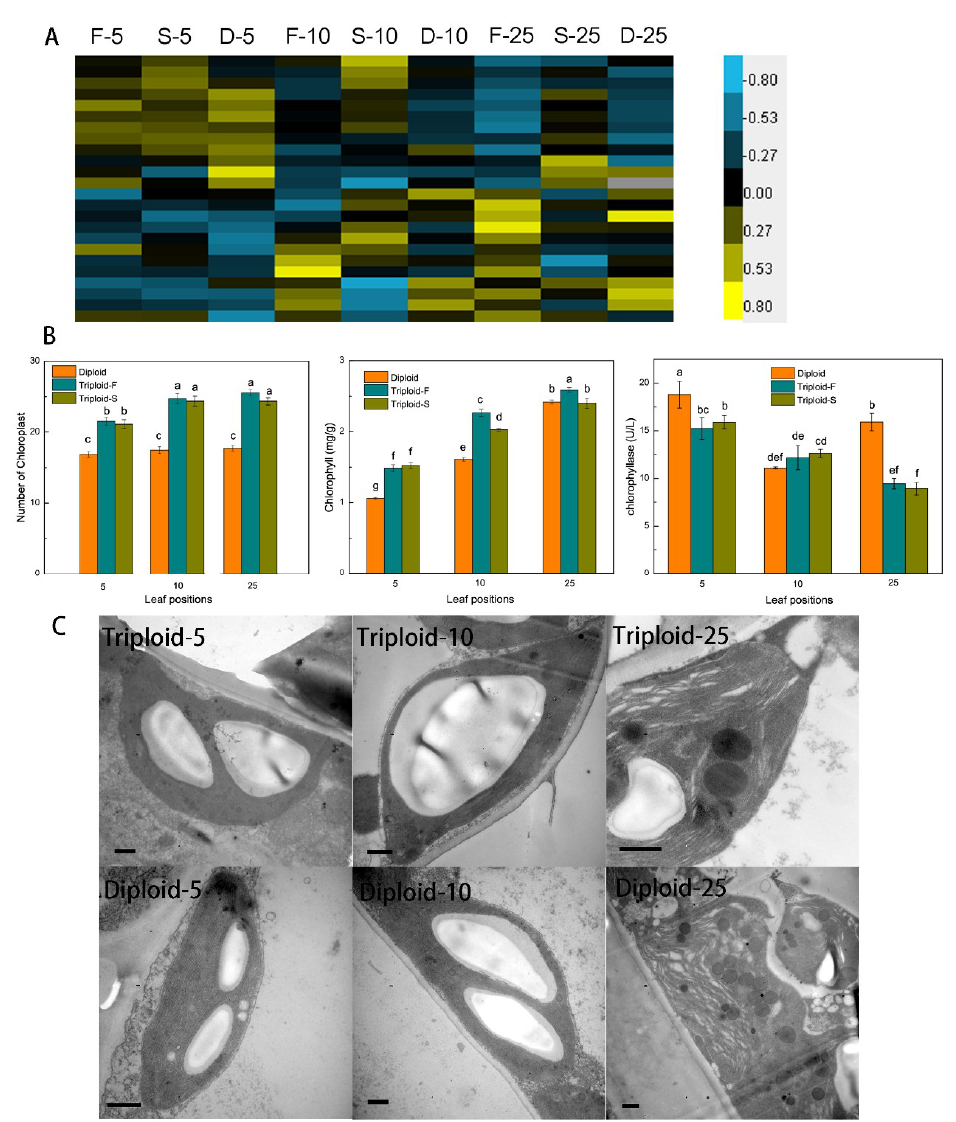
Figure 2. Chlorophyll synthesis and degradation in triploid-F, triploid-S and diploid plants. ( A ) Differentially expressed genes (DEGs) involved in chlorophyll synthesis and metabolism at different leaf canopy positions when triploid-F and triploid-S plants were compared to diploid plants; ( B ) The number of chloroplasts, chlorophyll content and chlorophyllase activity in triploid-F, triploid-S and diploid plants, different lowercase letters represent significant differences at p < 0.05; ( C ) Chloroplast ultrastructure in the 5th, 10th and 25th leaves in allotriploid and diploid plants. Bar = 10 µm. CLH , which is involved in chlorophyll degradation, was significantly downregulated in the